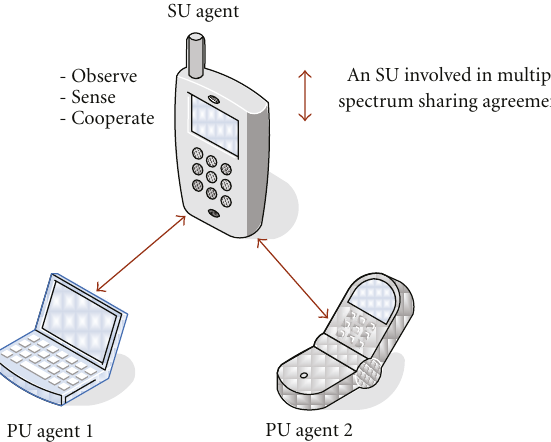
Figure 1: Spectrum sharing under an ad hoc